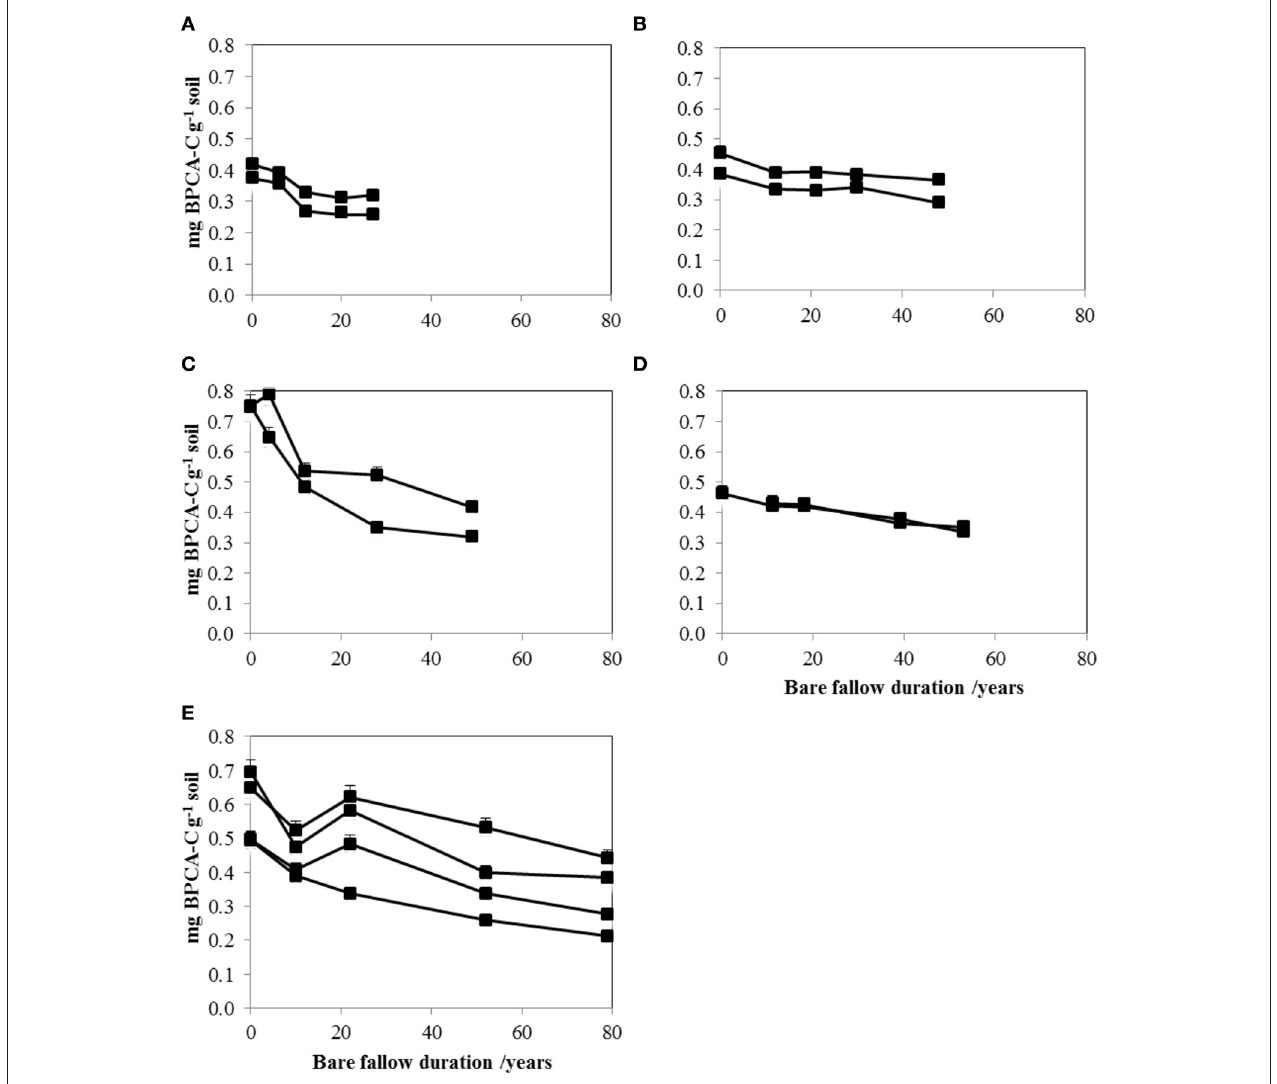
FIGURE 1 | Contents of native pyrogenic organic carbon (PyOC) in soil decrease with time at all LTBF sites and for all field replicates (mg BPCA-C g − 1 soil, time in years): Askov (A) , Grignon (B) , Rothamsted (C) , Ultuna (D) , and Versailles (E) . Each line corresponds to an experimental plot. Error bars represent PyOC variability within analytical replicates (always <